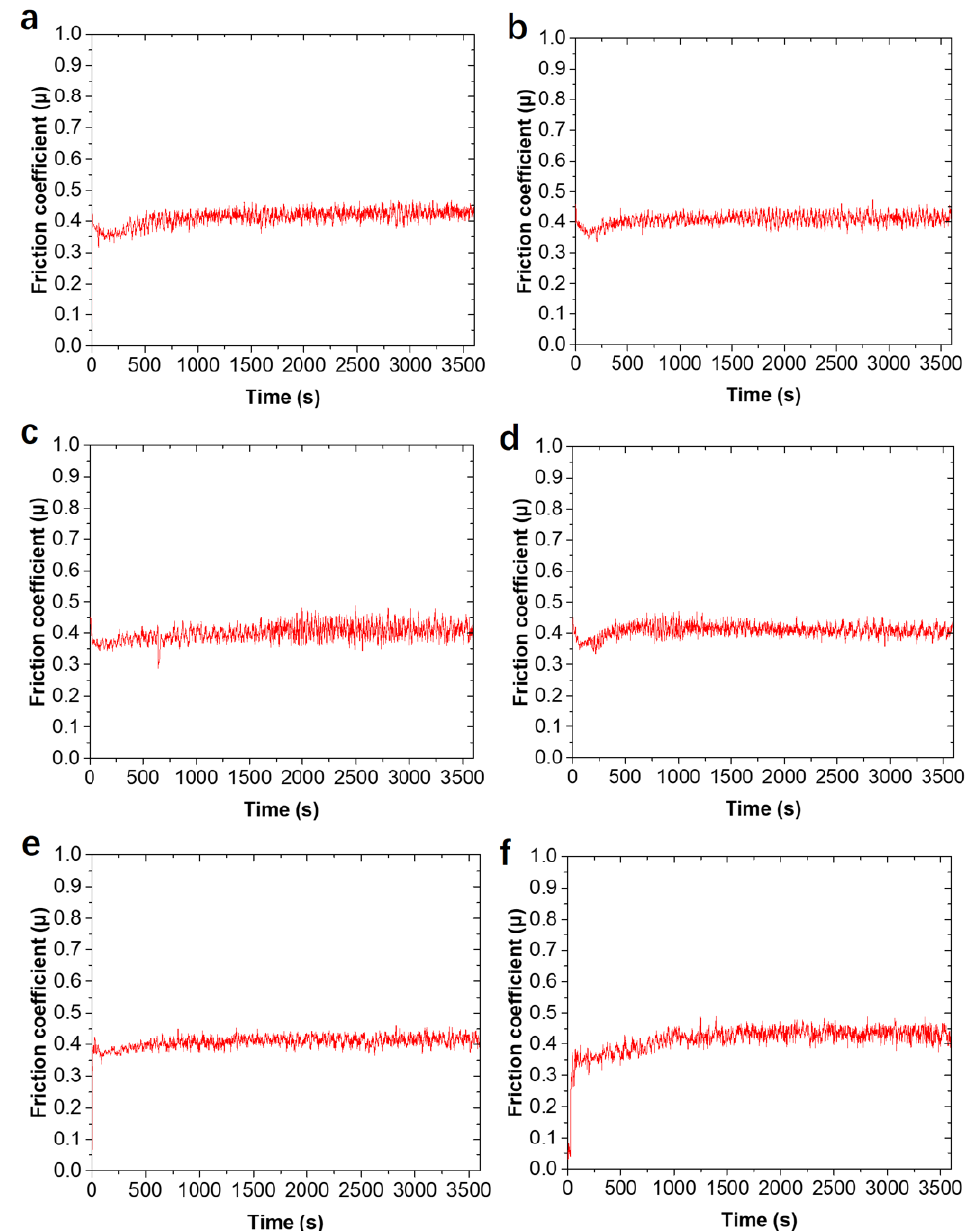
Figure 6. ( a – f ) Curves of friction coefficient versus time at 30 °C, 100 °C, 150 °C, 200 °C, 250 °C and 300 °C.